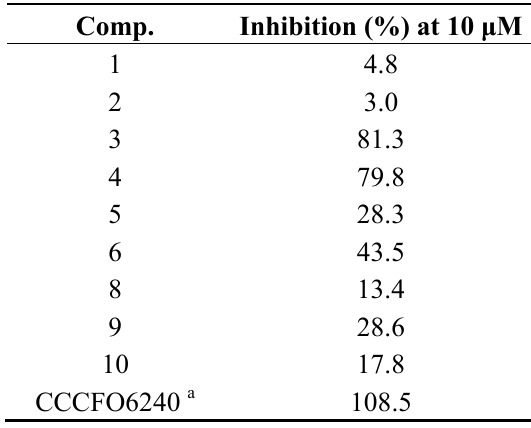
Table 2. The inhibition to PTP1B activities of compounds 1 – 6 , 8 – 10 .